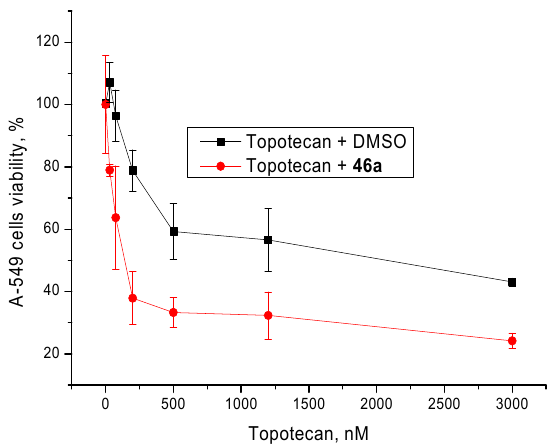
Figure 3. Dose-dependent action of topotecan in combination with 5 µ M of 46a on A-549 cells viability.